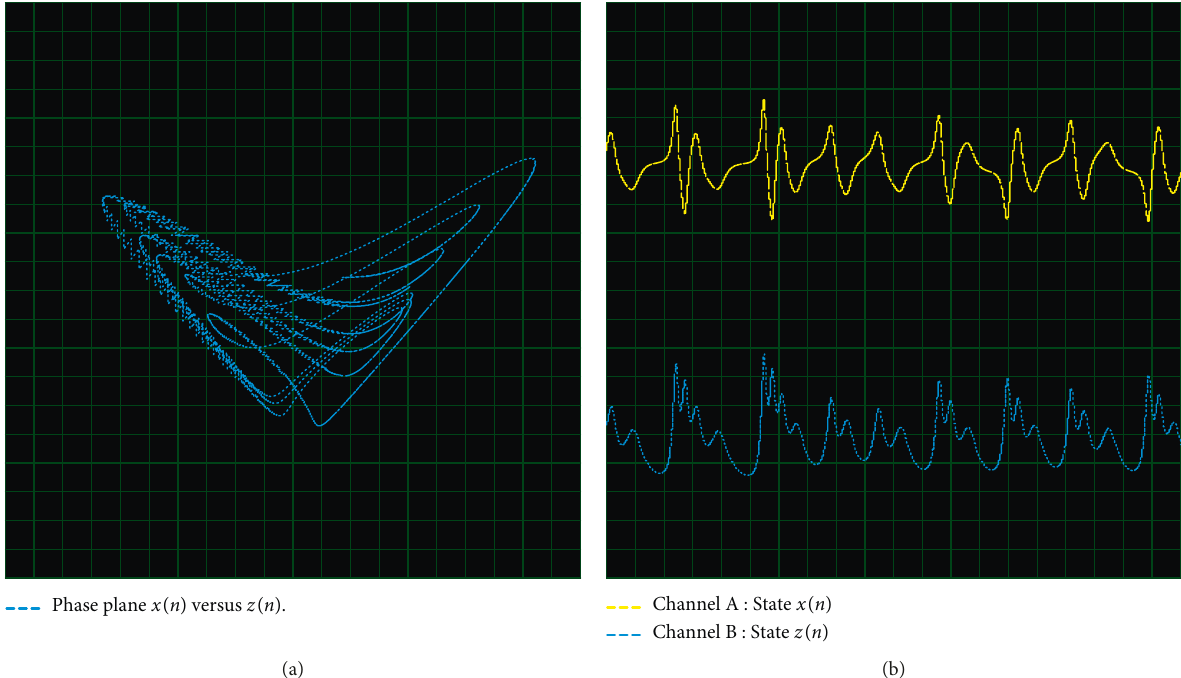
� 0.002. (a) Phase plane x max ( n ) versus z ( n ) and (b) evolution of state